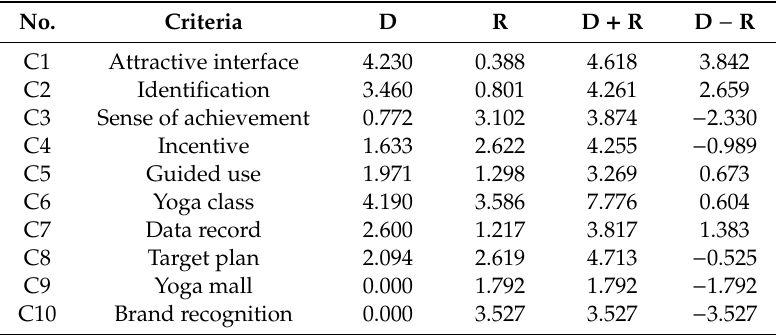
Table 5. Prominence and relation of each criterion.